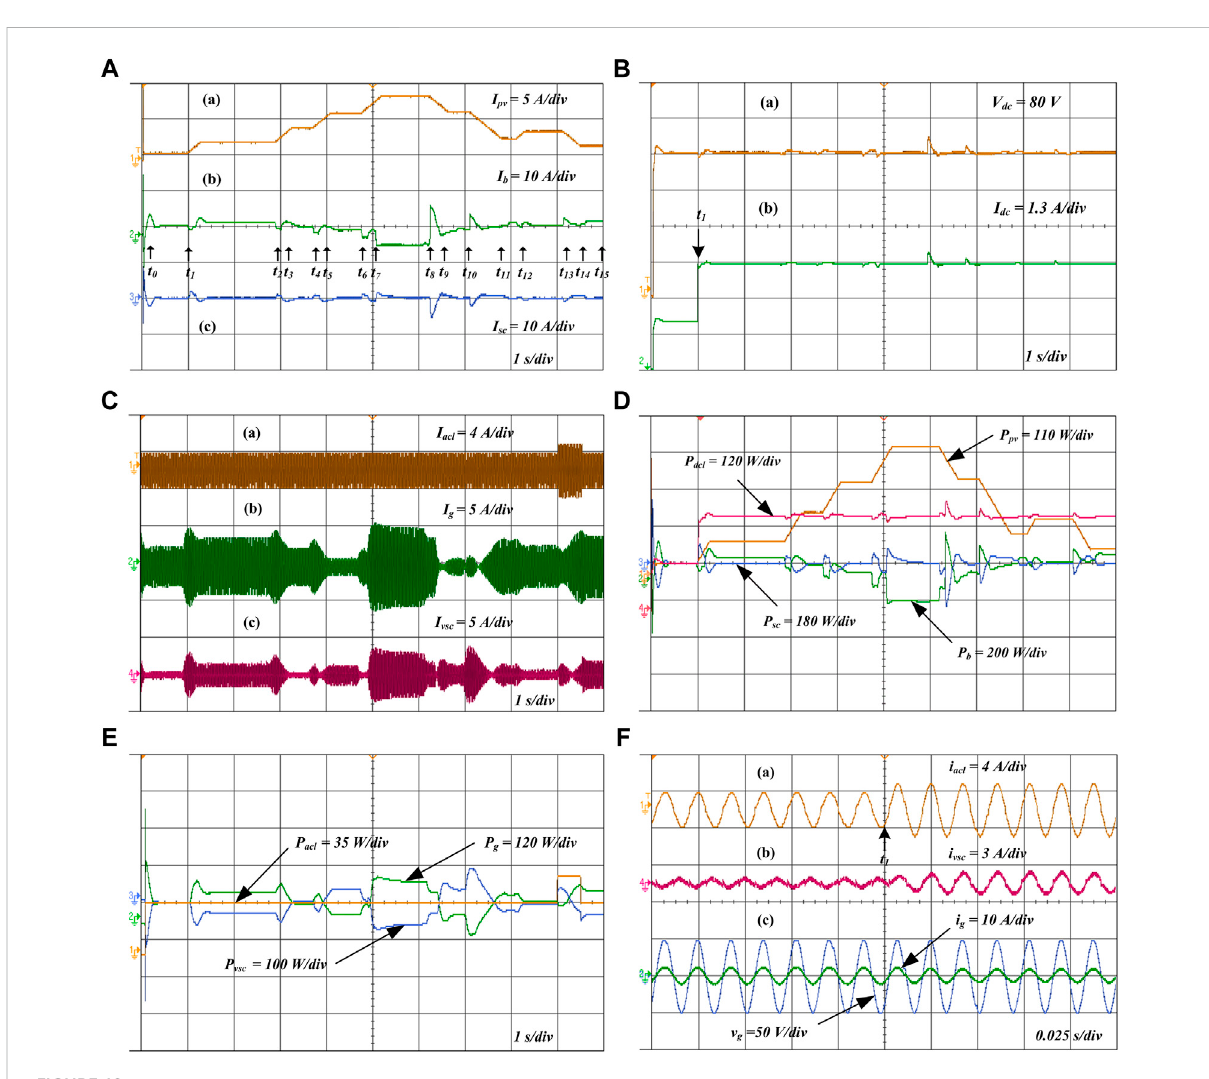
FIGURE 19 (A) HIL results: (a) PV, (c) BS, and (c) SC currents. (B) HIL results: (a) DC-link voltage, (b) DC load current. (C) HIL results: (a) AC load, (b) grid, and (c)VSCcurrents. (D) HILpowerresultsforPV,BS,SC,andDCloadunderseamlessmodeofoperation. (E)